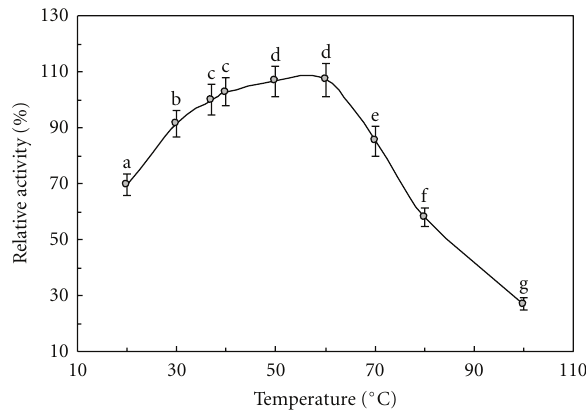
Figure 5: E ff ect of temperature on activity of the purified protease. Results are presented as mean ± SD ( n = 3). Di ff erent letters (e.g., a, b, c, and d) next to the data points indicate statistically significant di ff erence ( P < 0 . 05) when the data are analyzed by analysis of variance followed by Duncan’s multiple range